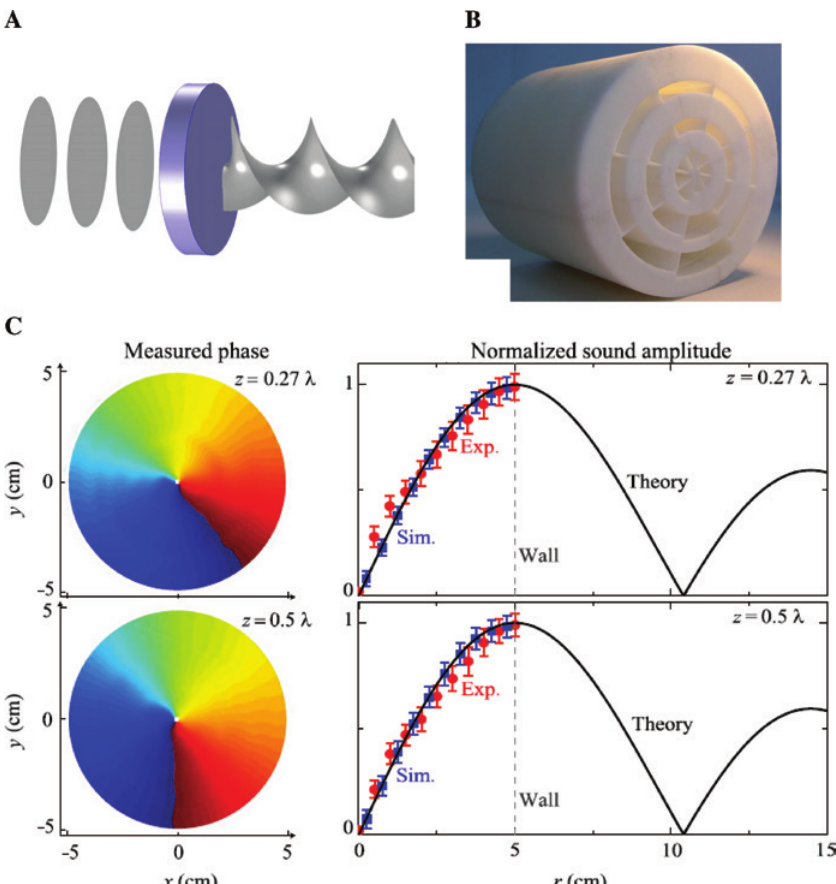
Figure 10: Metasurface-based conversion of acoustic resonance to orbital angular momentum. (A) Schematic of the mechanism of converting acoustic resonance to orbital angular momentum. (B) Experimental sample (photo). (C) Simu- lated and measured results of the phase profile and sound amplitude on two different cross sections (reprinted from Ref.